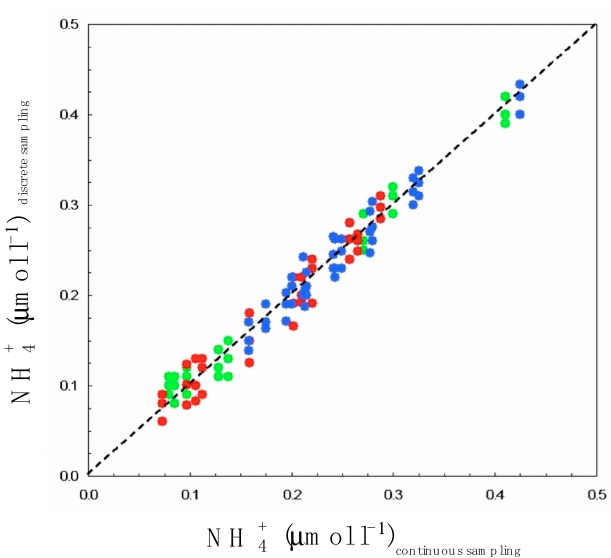
Figure 2. Mean values of ammonium times series recorded in 1996, 1997, and 1998, plotted against the ammonium concentrations simultaneously estimated from sub-surface Niskin bottle samples. The resulting highly significant linear regression ( p < 0.01) demonstrates the validity of our high-resolution sampling procedure. The different colors correspond to sampling under different flow speed v conditions: red ( v ~ 1 m s − 1 ; i.e., ε ~ 6 × 10 − 4 m 2 s − 3 ), blue ( v ~ 0.5 m s − 1 , i.e., ε ~ 7.5 × 10 − 5 m 2 s − 3 ), and green ( v ~ 0.2 m s − 1 , i.e., ε ~ 4.8 × 10 − 6 m 2 s − 3 ). The dissipation rate of turbulent energy ε (m 2 s − 3 ) were estimated from the velocity of the tidal flow v as ε = φ v 3 / z , where z is the depth of the water column ( z ~ 10 m) and φ is a constant, φ = 0.006; see Equation (15) below.